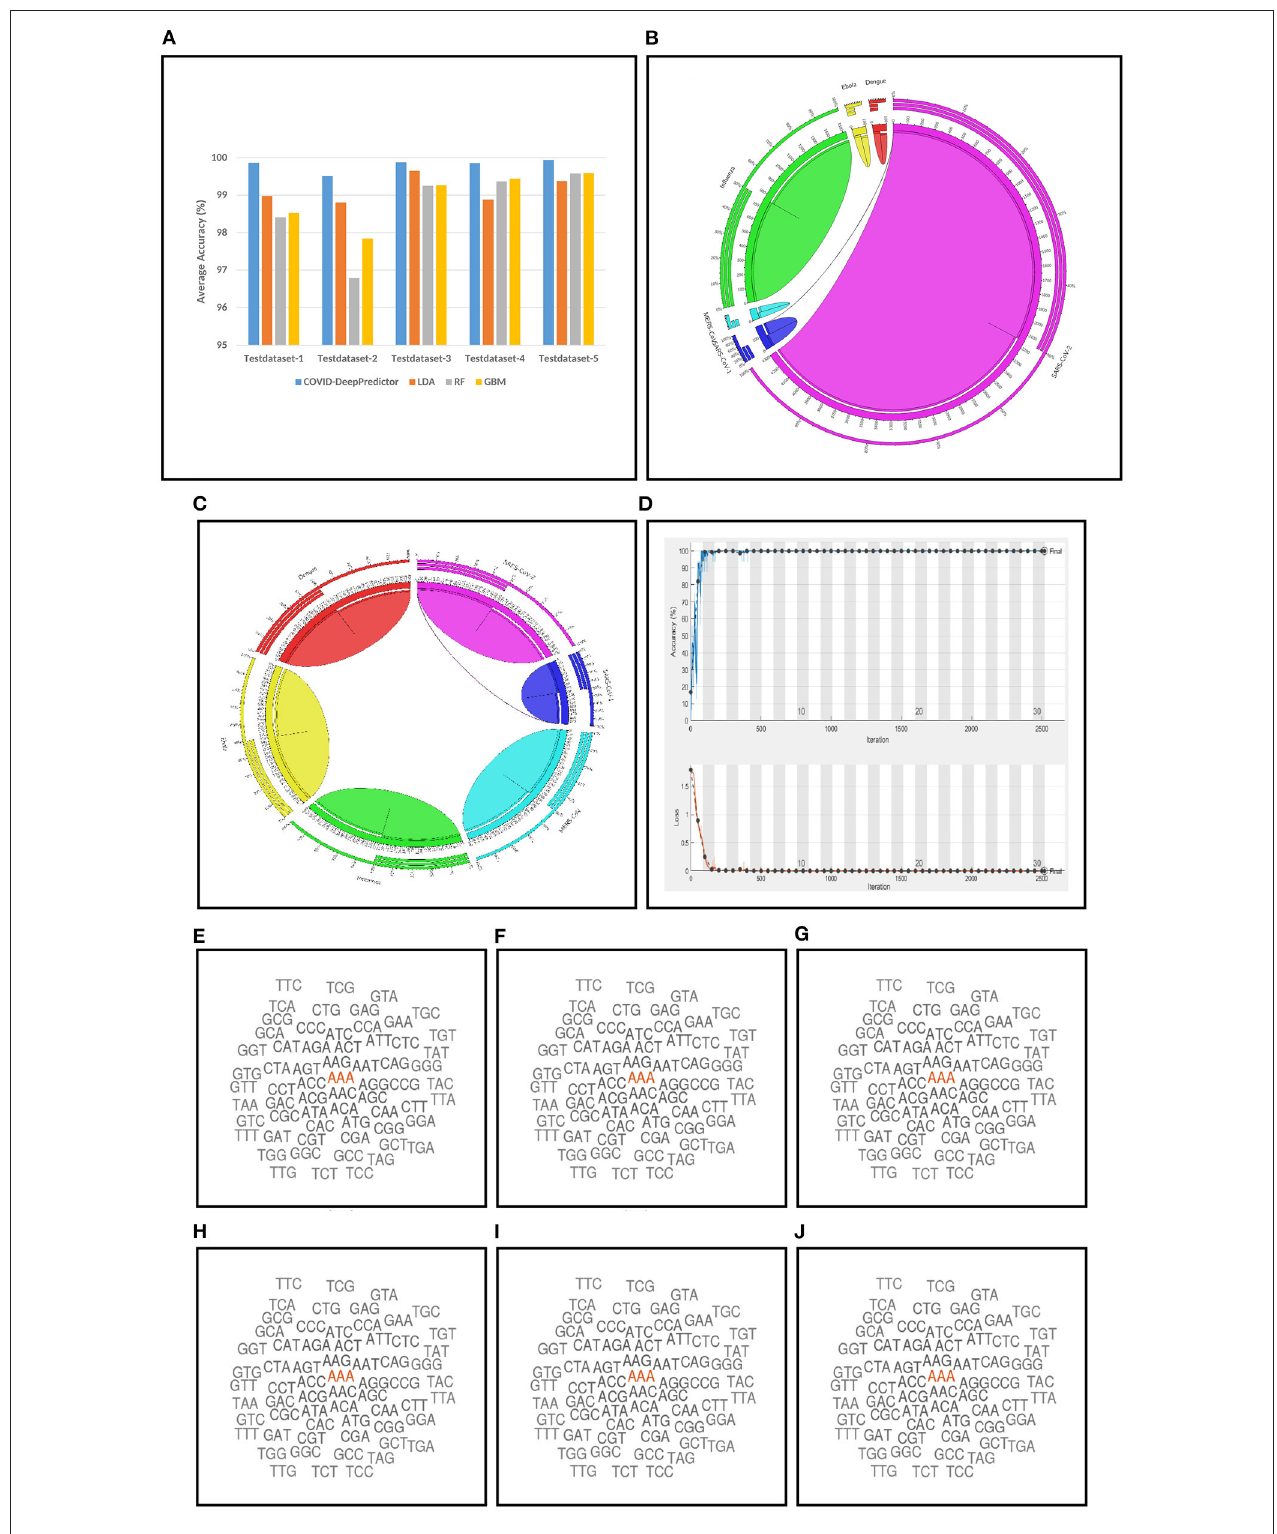
FIGURE 4 | Results related to COVID-DeepPredictor. (A) Prediction performance of COVID-DeepPredictor and other compared methods in terms of average accuracy for the five test datasets. Circos plots of confusion matrix for COVID-DeepPredictor ( k =3) for (B) Testdata-1 (C) Testdata-2. (D) Convergence plot of COVID-DeepPredictor. Word cloud of k -mer descriptors ( k =3) of genome sequences for (E) SARS-CoV-1 (F) MERS-CoV (G) SARS-CoV-2 (H) Ebola (I) Dengue (J) Influenza.